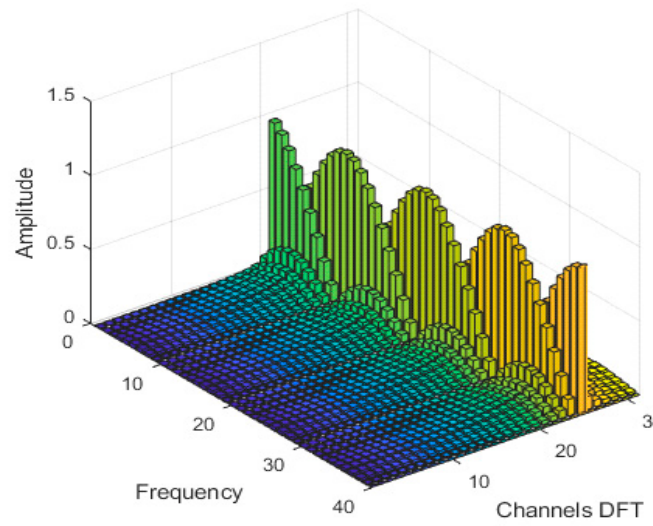
Figure 3. Frequency response of DFT channels.